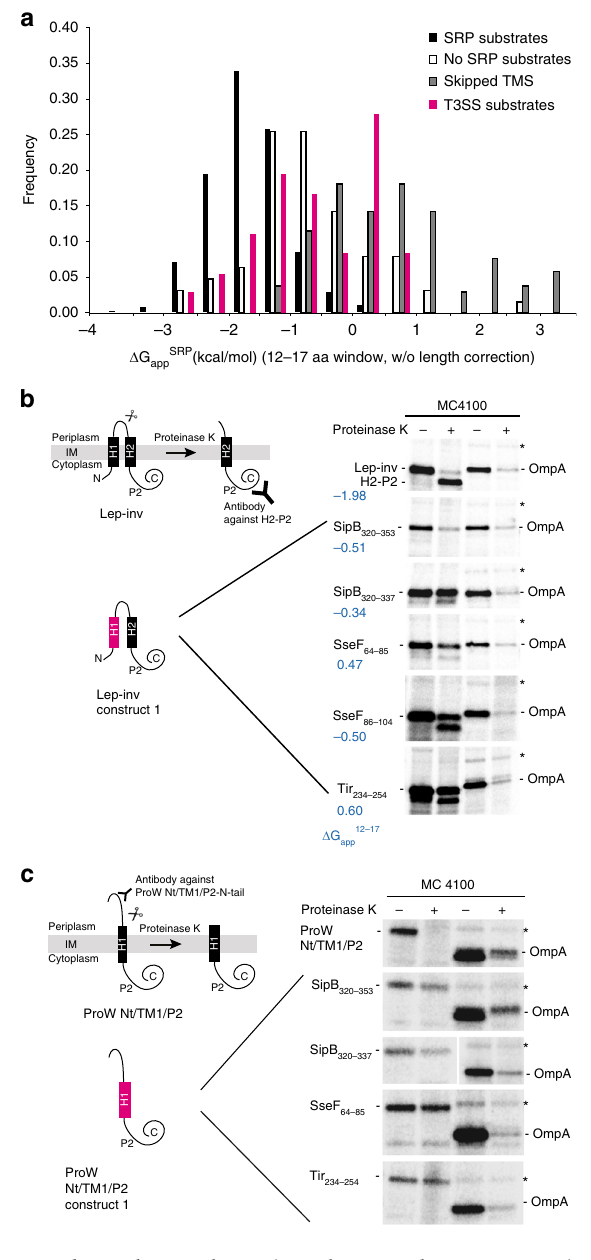
Fig. 3 Membrane targeting potential of TMS of type III-secreted transmembrane proteins ( a ) Calculation of Δ G app for the SRP-targeting window of 12 – 17 aa ( Δ G app SRP ) for transmembrane proteins of type III- secreted transmembrane proteins (red) compared to E. coli transmembrane proteins. The classi fi cation of E. coli membrane proteins is according